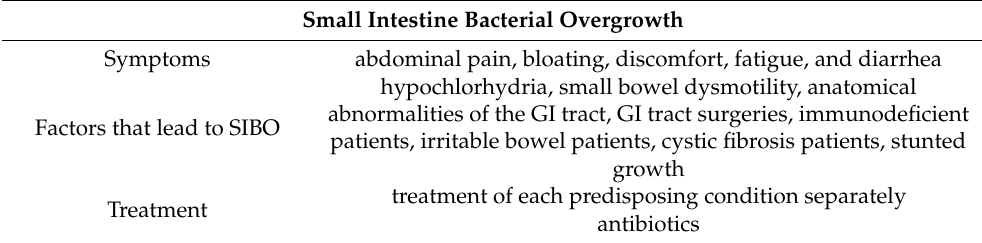
Table 2. Small intestine bacterial overgrowth major findings. Data from